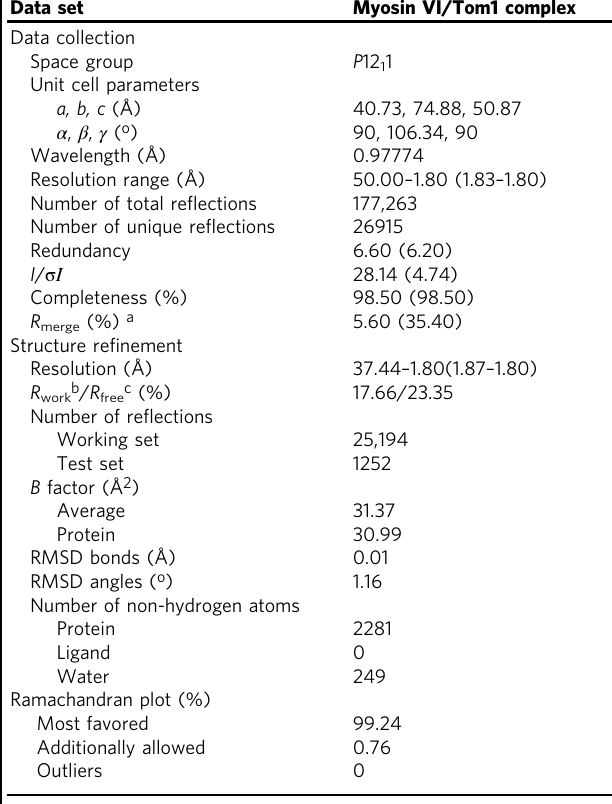
Table 2 Data collection and re fi nement statistics Data